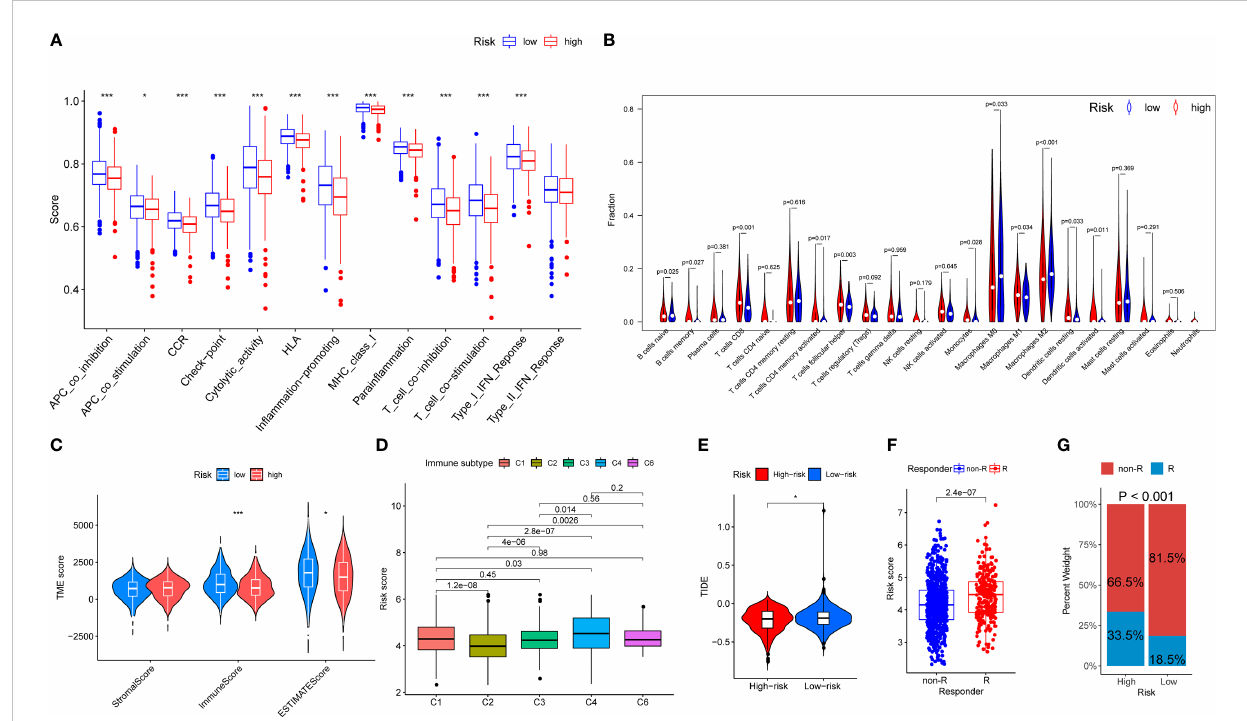
FIGURE 6 The landscape of immune function and immune cell in fi ltration between the high- and low-risk group in the TCGA cohort. Red represents high-risk samples; blue represents low-risk samples. * P < 0.05, ** P < 0.01, *** P < 0.001. (A) Barplot showing differences of immune functions between the low- and the high-risk group. (B) Violin plot showing differences of in fi ltrating immune cell types between the low- and the high-risk group. (C) Comparison of tumor microenvironment scores calculated by ESTIMATE between the low- and the high-risk group. (D) Comparison of risk scores between different immune subgroups. (E) Comparison of tumor microenvironment scores calculated by TIDE between the low- and the high-risk group. (F) Comparison of risk scores between different responder subgroups. (G) Comparison of the immunotherapy responding proportion between the low- and the high-risk